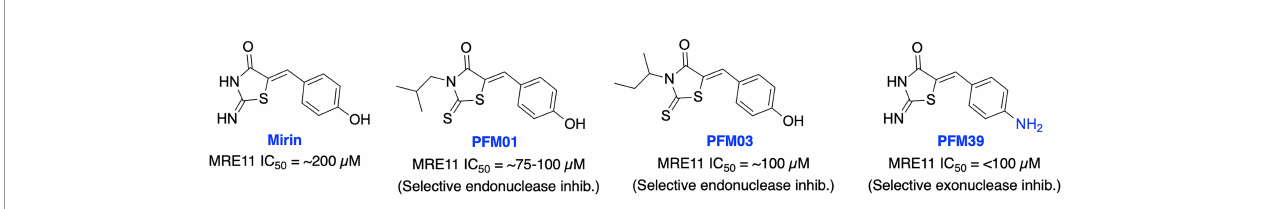
FIGURE 8 | Small molecule inhibitors targeting MRE11 with their respective IC50 values for inhibition of